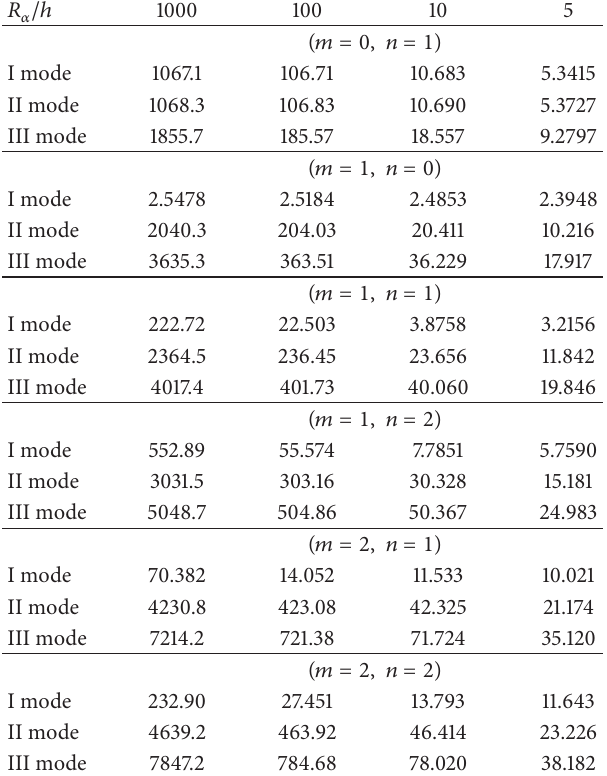
eigenvalues. We are interested to the null space of matrix E that means finding the ( 6 × 1 ) eigenvector related to the minimum of the six eigenvalues proposed. This null space is, for the chosen frequency 𝜔 𝑙 , the vector U calculated at the